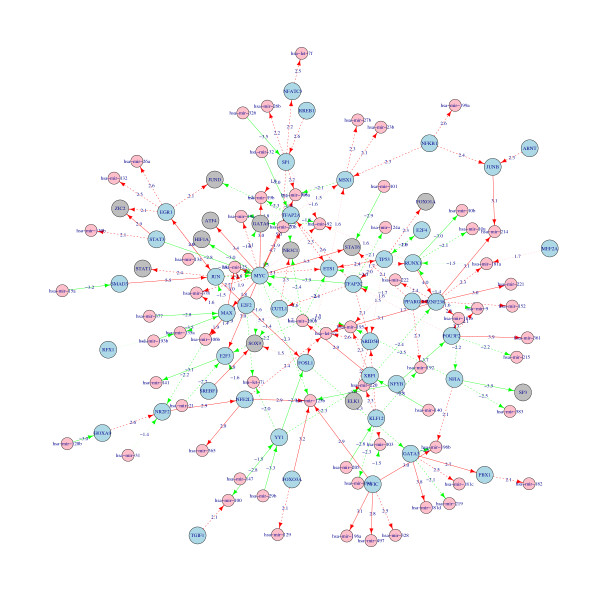
A sub-network from the human cancer combinatorial gene regulatory network composed of regulators only. Pink nodes indicate miRNAs; blue and grey nodes indicate TFs regulating or not regulating other regulators. Regulation relationships are differentially designated with three different edges according to the linear regression p-value: solid lines (most credible, p < 0.01), dashed line (medium credible, 0.01 < p < 0.05), and dotted line (less credible, p > 0.05). Numbers tagged with each edge are the T-statistics of the corresponding regulation.